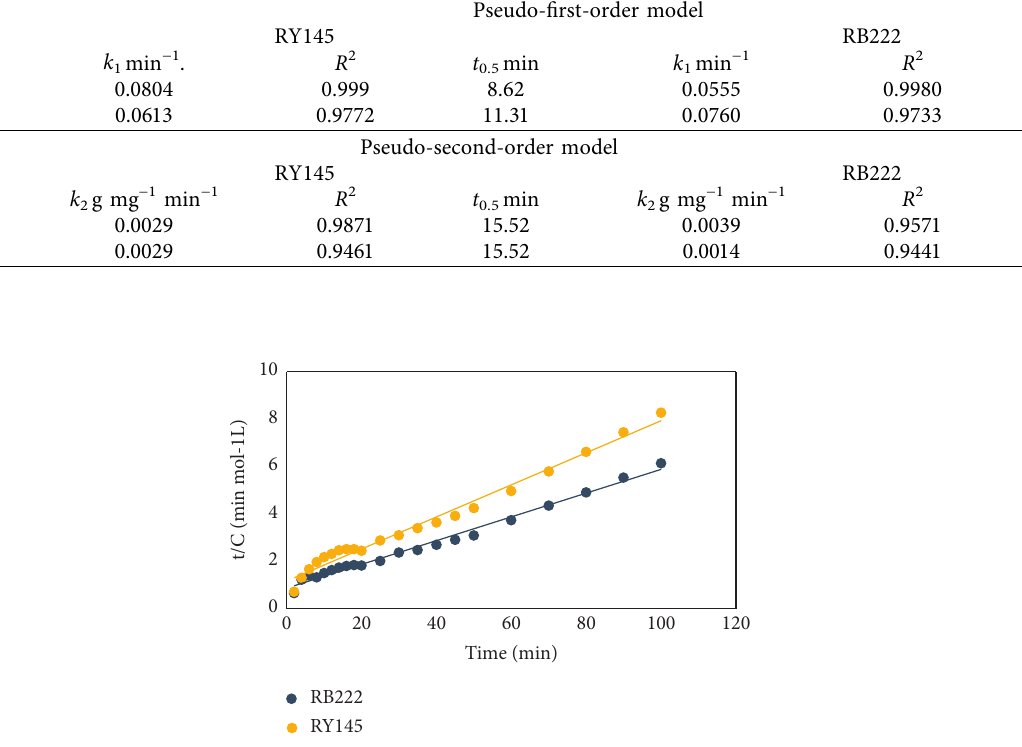
Figure 17: Pseudo - second-order kinetic model for extraction of RY145 and RB222 dyes at concentration 6 × 10 − 5 mol/10ml by SDS surfactant concentration 9 × 10 − 2 mol/10 ml.